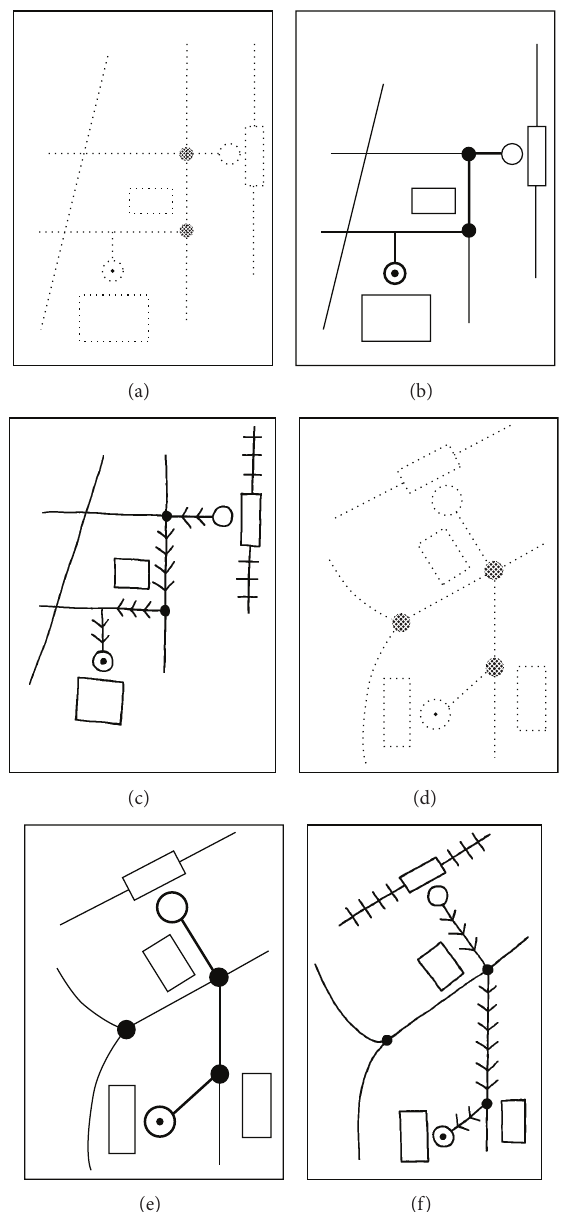
Figure 15: Maps for Sessions 1 and 2: (a) Edel map for Session 1, (b) PPT map for Session 1, (c) hand-drawn map for Session 1, (d) Edel map for Session 2, (e) PPT map for Session 2, and (f) hand-drawn map for Session